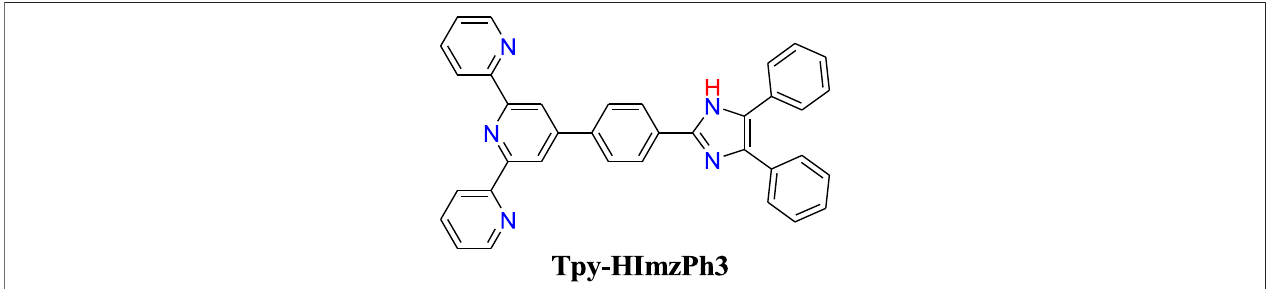
CHART 1 | Chemical structure of the terpyridyl-imidazole based receptor.